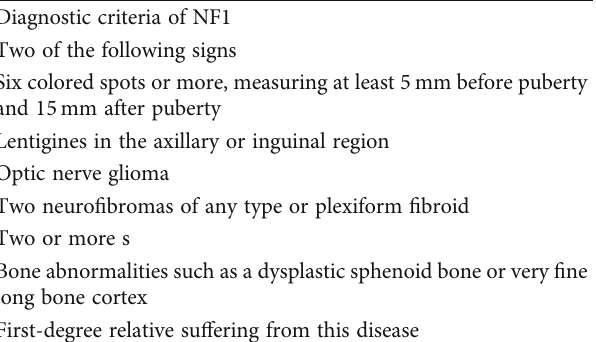
Table 1: Clinical diagnostic criteria for neuro fi bromatosis type I. Diagnostic criteria of NF1 Two of the following signs Six colored spots or more, measuring at least 5 mm before puberty and 15mm after puberty Lentigines in the axillary or inguinal region Optic nerve glioma Two neuro fi bromas of any type or plexiform fi broid Two or more s Bone abnormalities such as a dysplastic sphenoid bone or very fi ne long bone cortex First-degree relative su ff ering from this